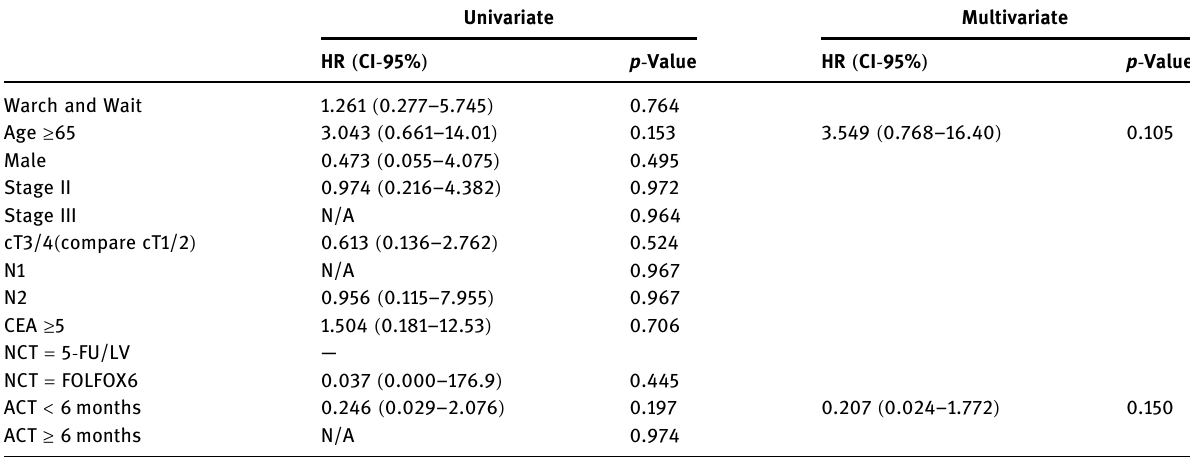
Table 4: Cox regression analysis of risk factors for